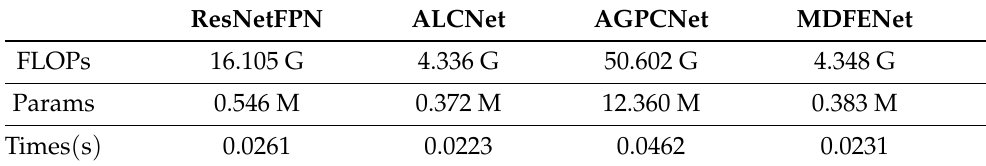
Table 2. Computational complexity and running time of deep learning algorithms.